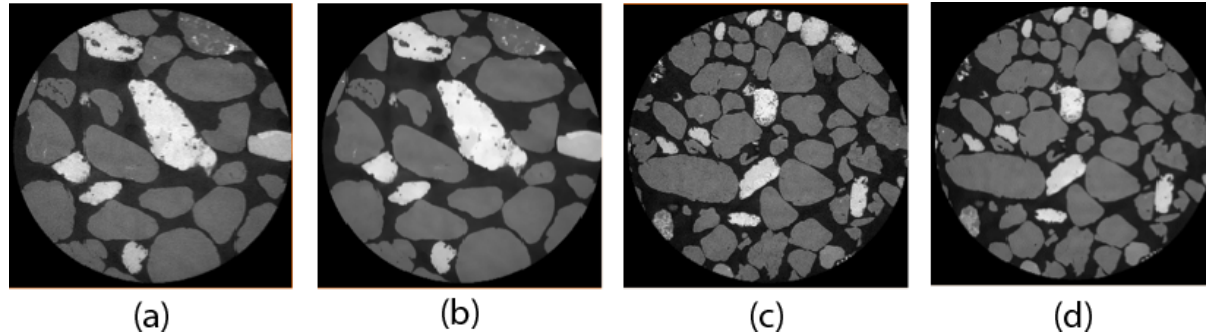
Figure 4. (a) Raw and (b) filtered images of the Scarborough Beach sand sample; (c) raw and (d) filtered images of the Cottesloe Beach sand sample.